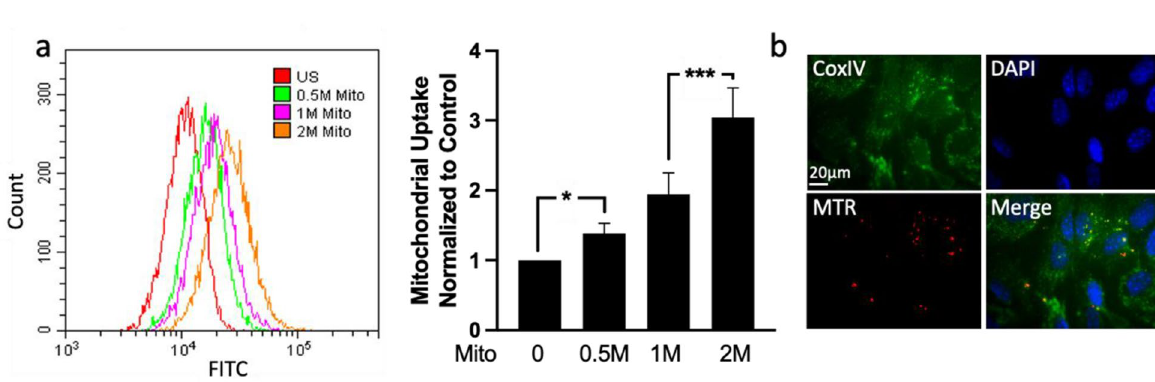
Figure 2. In vitro uptake of isolated mitochondria by retinal ganglion precursor-like cells. Isolated mitochondria from mouse liver were stained with mitotracker green (MTG) ( a ) or mitotracker red (MTR) ( b ) and transplanted into 100,000 661W cells during 18–24 hours of incubation. ( a ) Flow cytometry analysis of 661W cells transplanted with exogenous mitochondria showed an increase in fluorescence compared to control unstained cells, as demonstrated by a representative histogram plot (left) and by the quantitative bar graph (right), n = 4. *p < 0.05; ***p < 0.0003; Mito mitochondria, M million. ( b ) Immunofluorescence staining shows mitochondria (red) uptake by 661W cells, stained for CoxIV (endogenous mitochondria marker, green) and for the nuclear marker DAPI